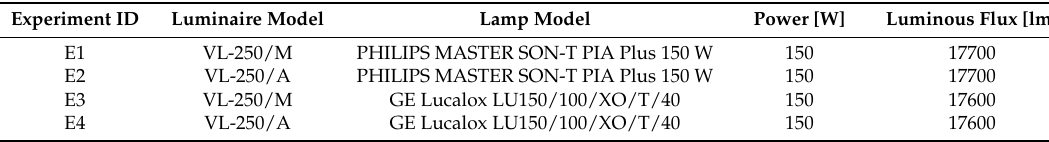
Table 1. Experiments combining different types of luminaires and